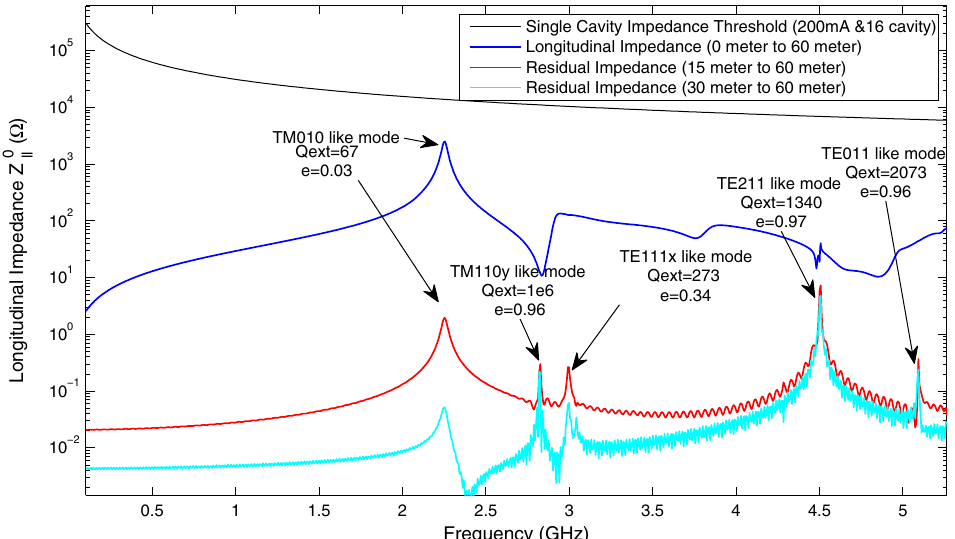
FIG. 10. Single-cavity longitudinal wake impedances Z 0 ∥ . Three impedance curves are compared: Z 60 m 0 curve), and Z 60 m 30 (cyan curve). m